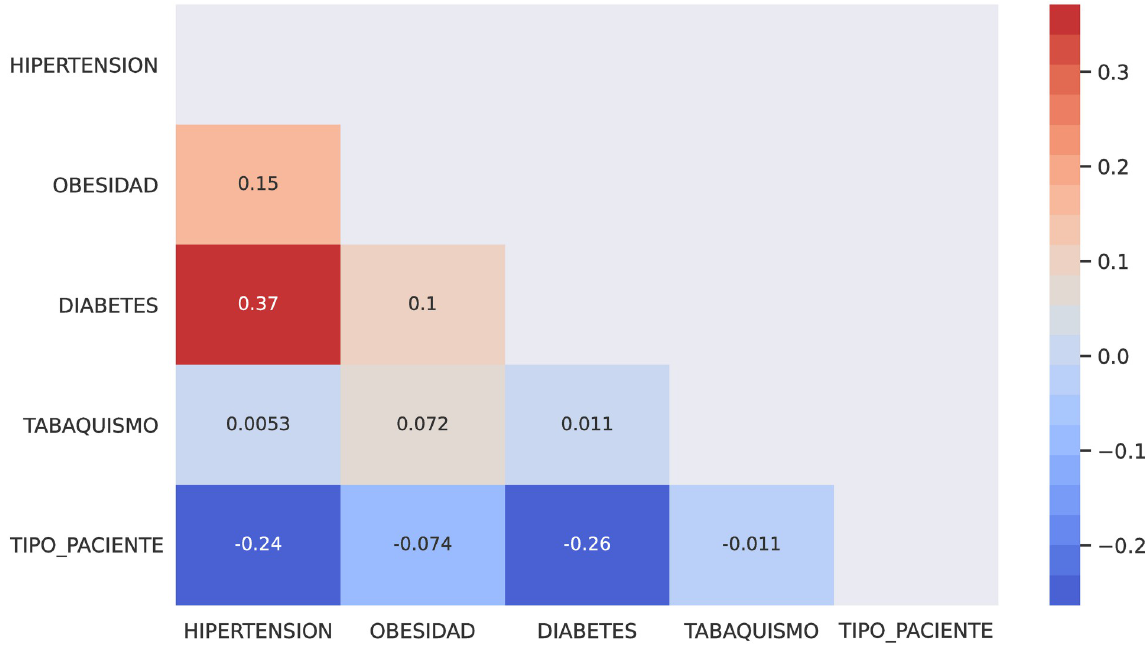
Fig 5. Covariance matrix of the most relevant chronic diseases with respect to the type of patient (outpatient/hospitalized) in Mexico.